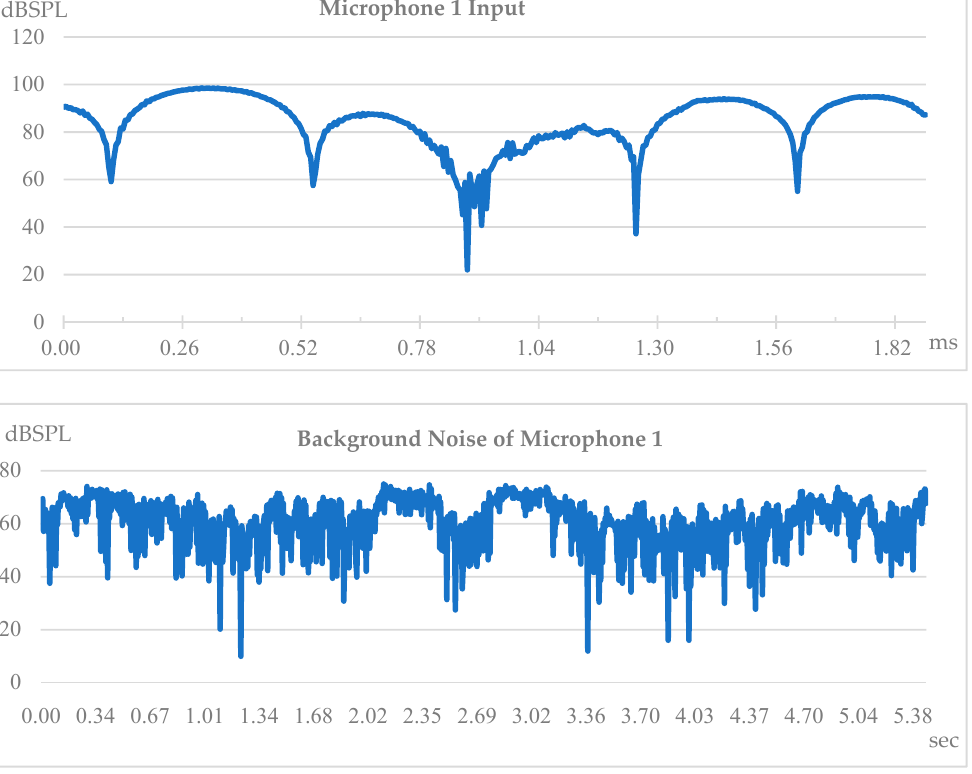
Figure 8. Acoustic source input ( top ) and background noise ( bottom ) of microphone 1.